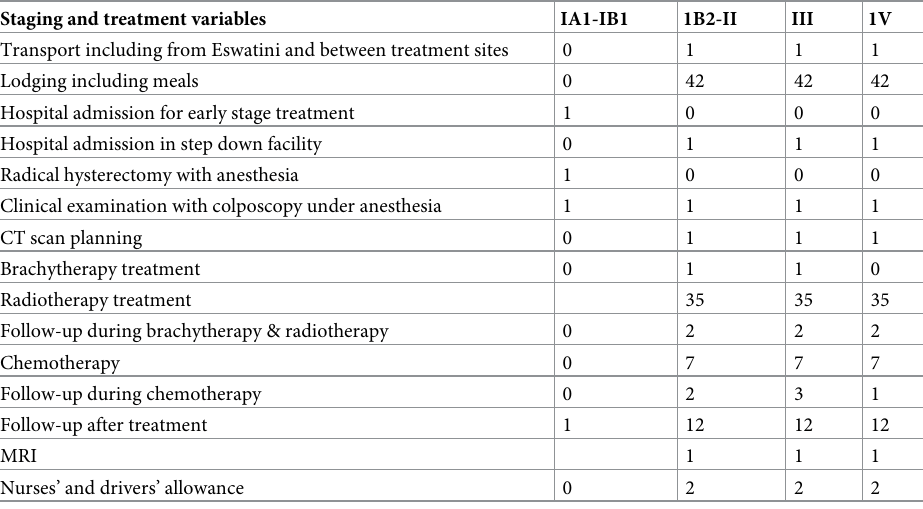
Table 3. Breakdown for staging and treatment variables for FIGO I-IV.